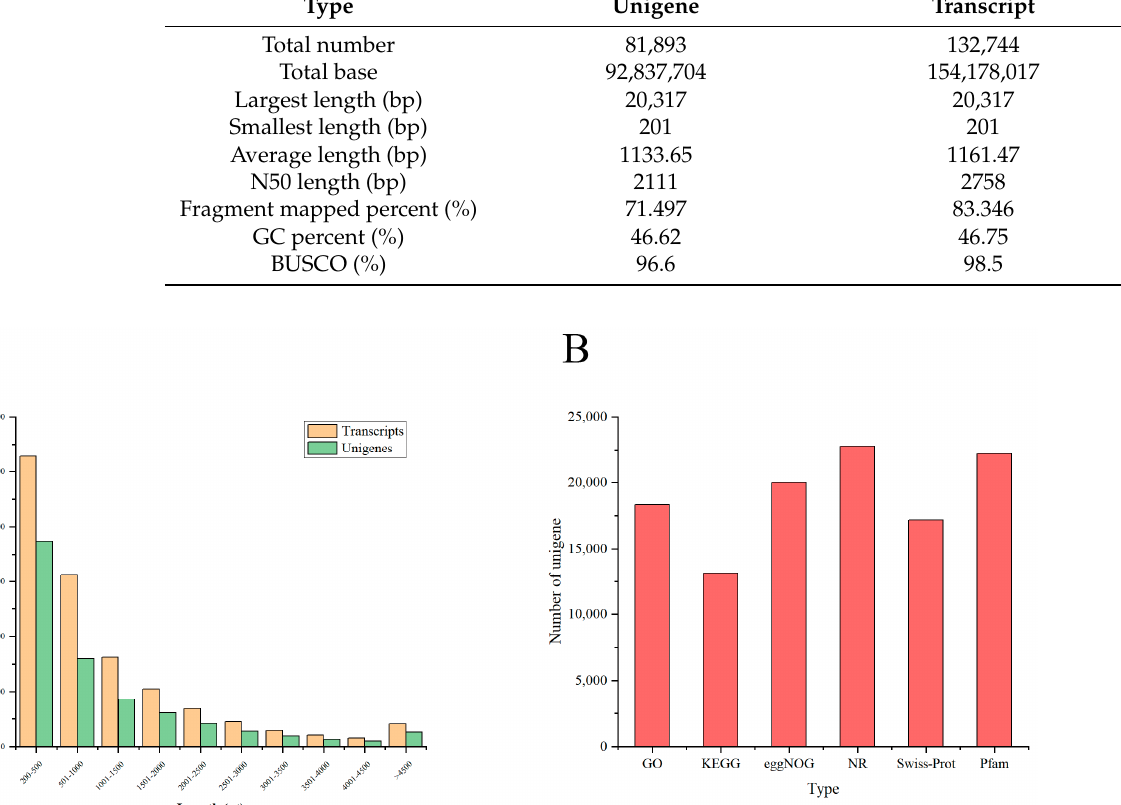
Figure 1. ( A ) Distribution of the length of unigenes and transcripts. The abscissa represents different length ranges of transcripts and unigenes, and the ordinate represents the number of transcripts and unigenes in a certain length range. ( B ) Functional annotation of unigenes from six databases (GO, KEGG, eggNOG, NR, Swiss-Prot, and Pfam). Table 2. Evaluation of the assembly results.